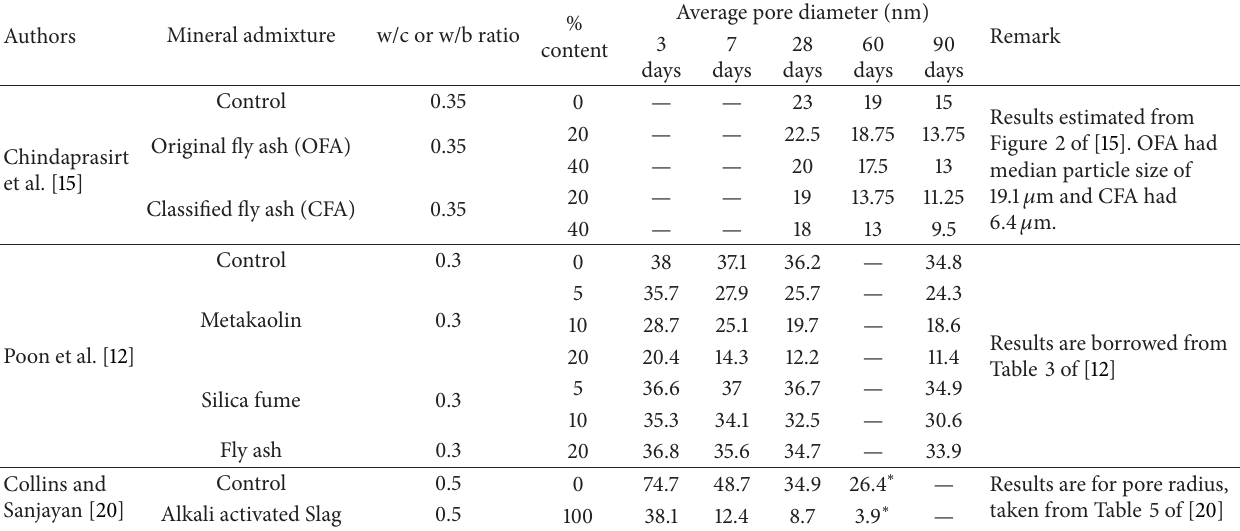
Table 1: Average pore diameter of cement replaced hardened